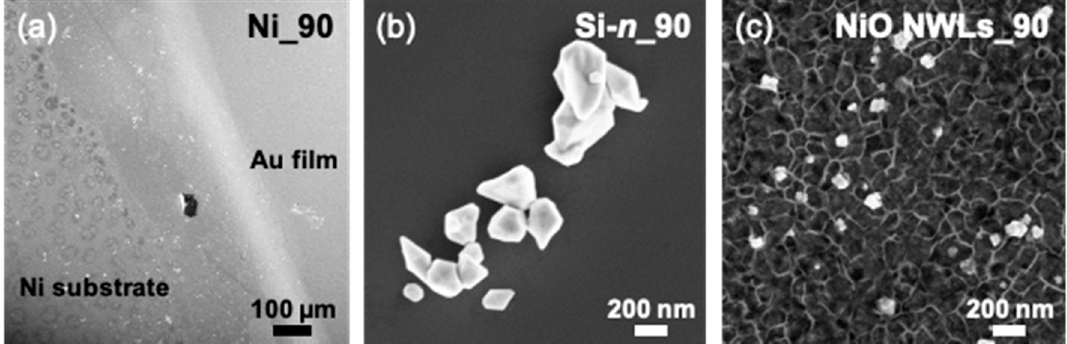
Figure 1. Plan-view SEM images of ( a ) Ni, ( b ) Si- n , and ( c ) NiO nanowalls (NWLs) samples obtained